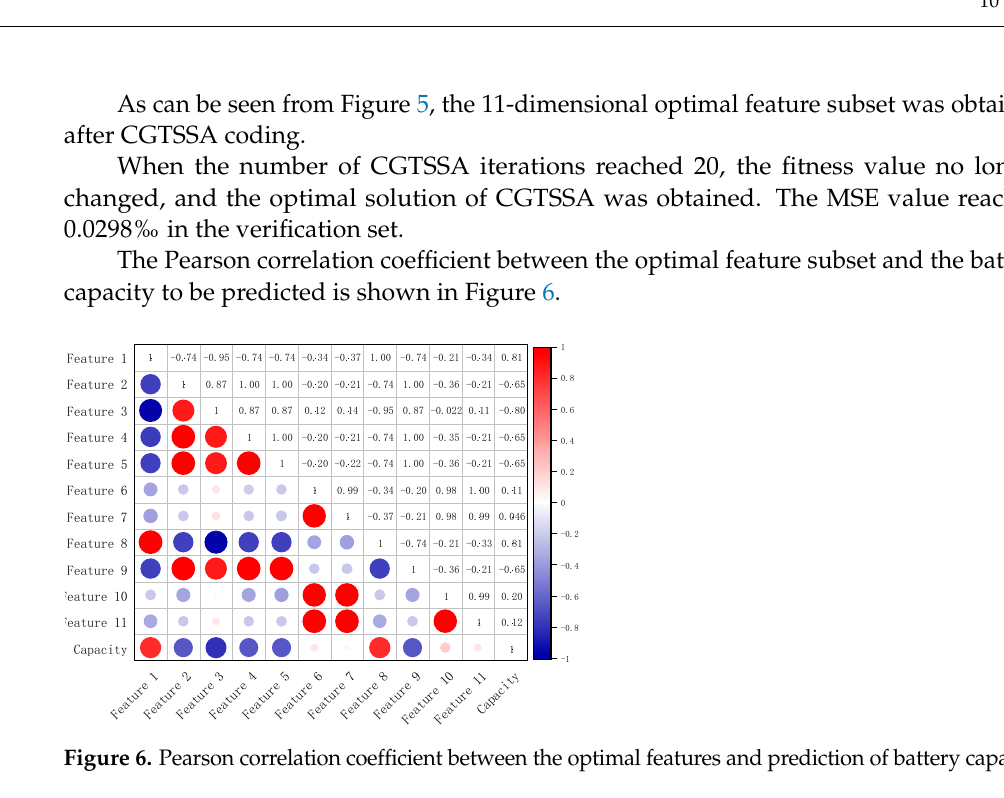
Figure 5. Fitness curve of CGTSSA screening health factors.